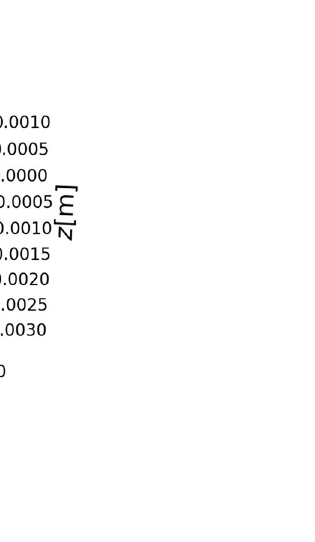
Figure 4. Left panel: Three-dimensional wave pattern at t 19 s. The parameters are the same as in Fig. 3. at t =